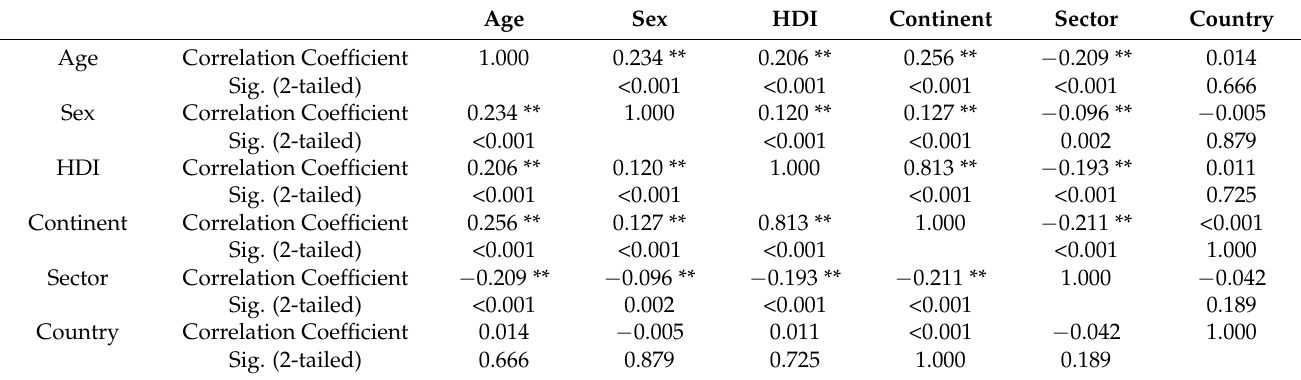
Table 16. Spearman’s matrix of non-parametric bivariate correlations. Age Sex HDI Continent Sector